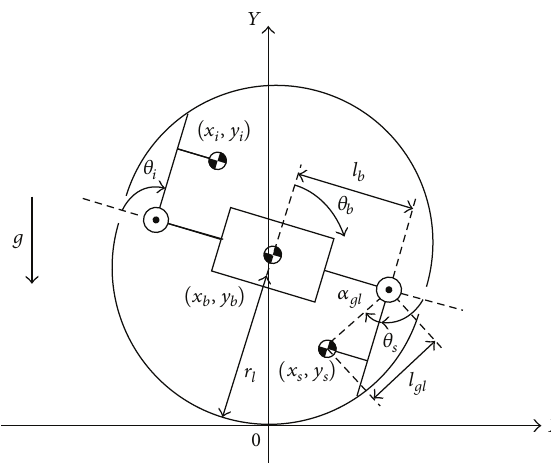
Figure 5: Transformed model diagram of the rolling huntsman- spider-inspired quadruped robot. A grounding leg is defined as the supporting leg and another leg is defined as the idling leg. The grounding point of the supporting leg is defined as the origin 0, which is switched to the point after switching each supporting